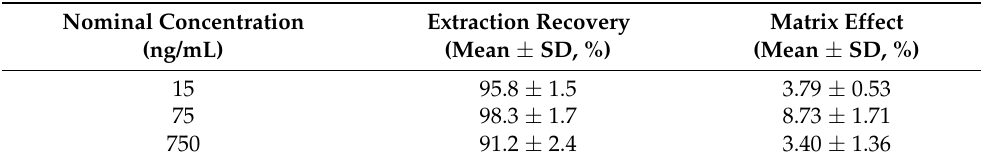
Table 3. Extraction recovery rates and matrix factors of the UPLC-MS/MS method for the analysis of OJT007 in rat plasma [ n = 6; mean ( ±